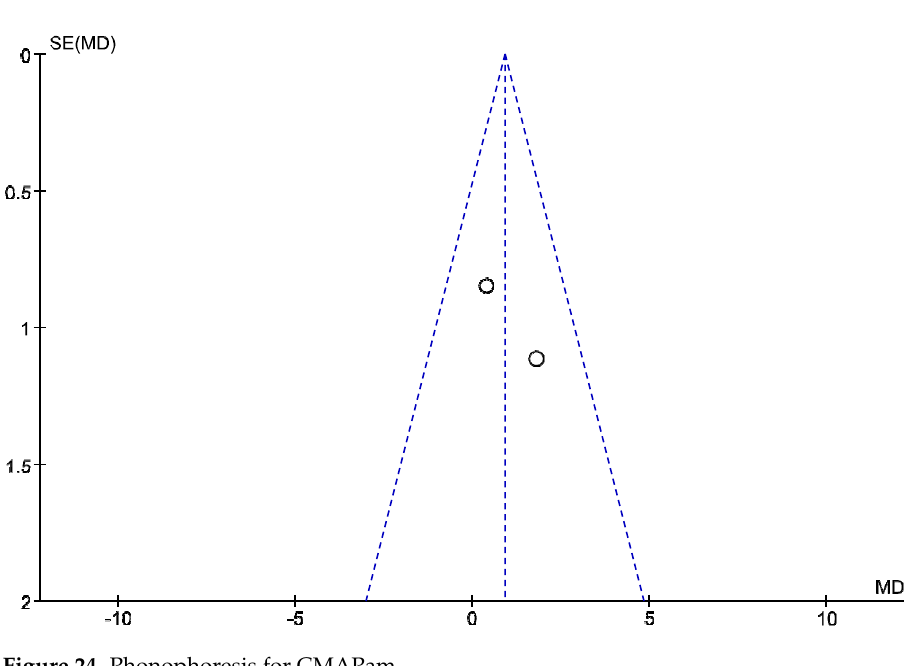
Figure 23. Phonophoresis for CNVS.